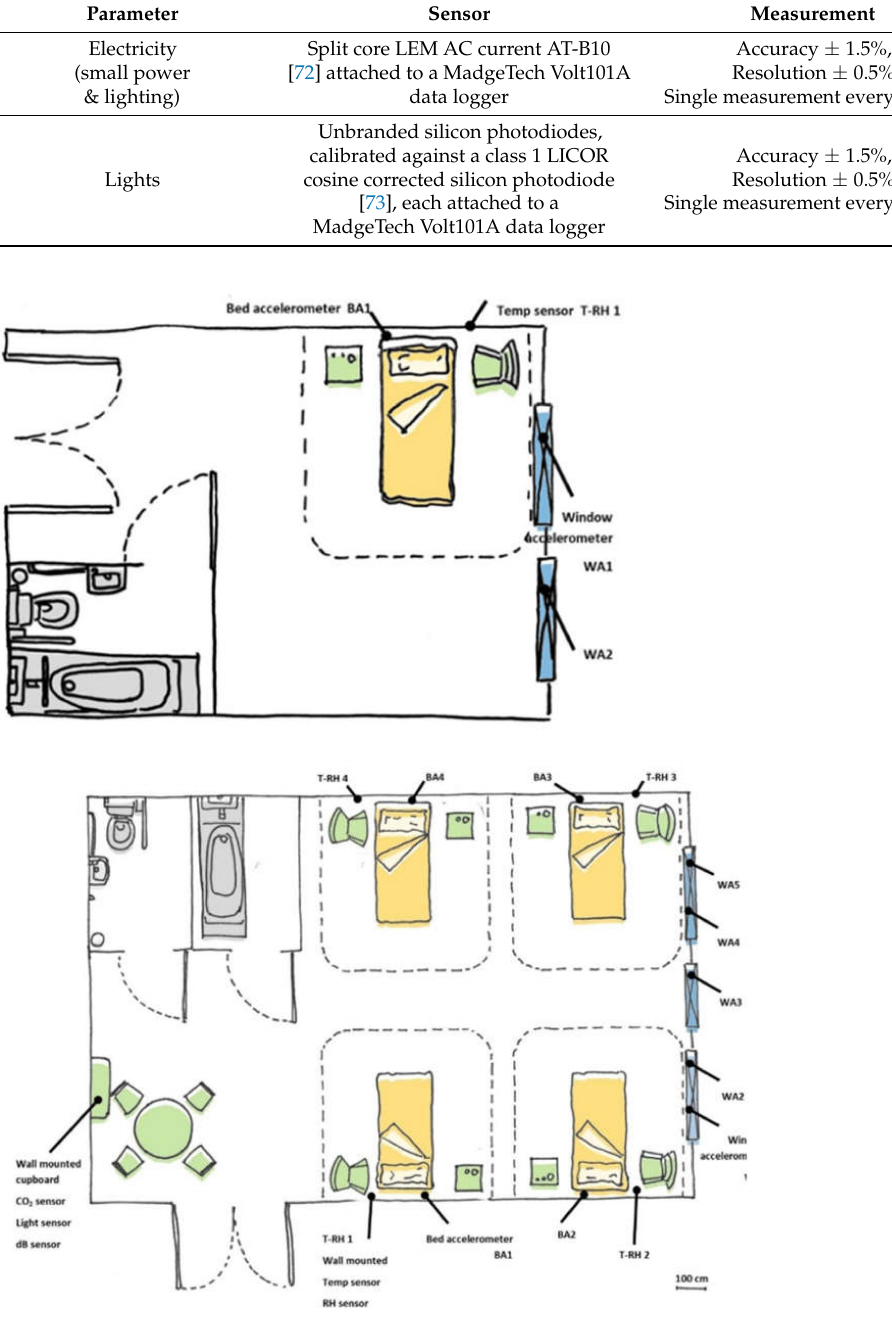
Figure 2. Study single room (TOP) and 4-bed patient bay layout (BOTTOM) and location of measuring equipment used on an older persons’ community hospital patient bay to measure the environment over the study (1 August 2017–30 April 2018). WA1 to WA5 = window accelerometers, BA1 to BA4 = bed accelerometers, T-RH 1 to T-RH 4 = air temperature and relative humidity monitors. The study measured electricity use via a set of three LEM split core current clamps (0–50 A, 0–10 V DC output) [72] attached to a MadgeTech Volt101A data logger. A set of current clamps and logger was fixed to the 3-phase electricity supply on the lighting distribution board and the small power distribution board for each of the three wards. The loggers were set to single measurement with a sampling frequency of every